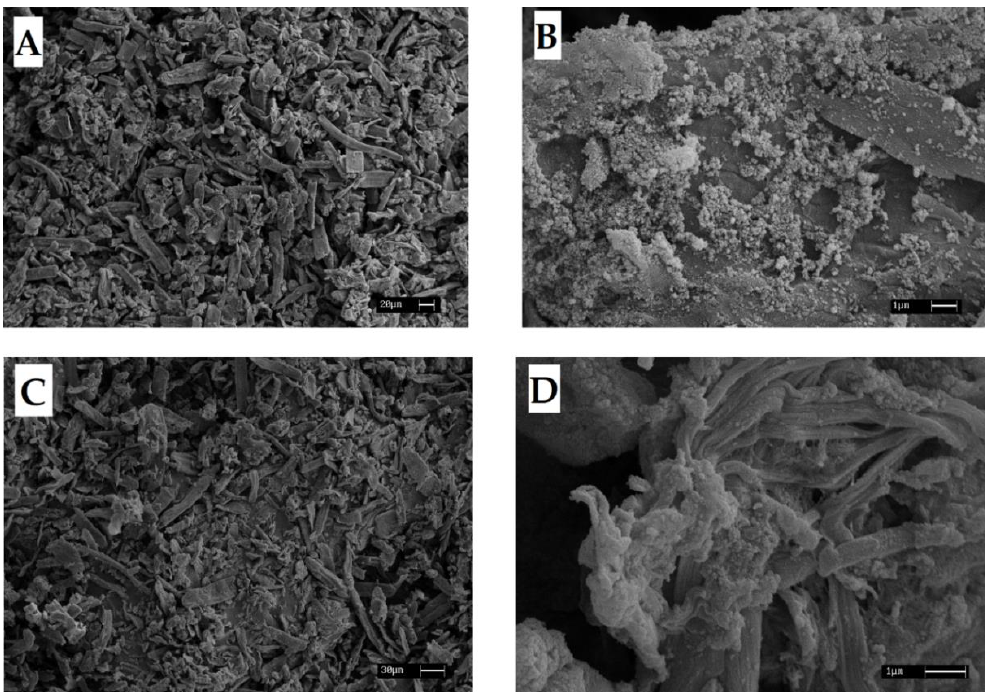
Figure 3. Morphological comparison between ( A ) CELL@Fe 3 O 4 (scale: 20 µ m), ( B ) CELL@Fe 3 O 4 (scale: 1 µ m), ( C ) SC@Fe 3 O 4 (scale: 30 µ m), and ( D ) SC@Fe 3 O 4 (scale: 1 µ m).